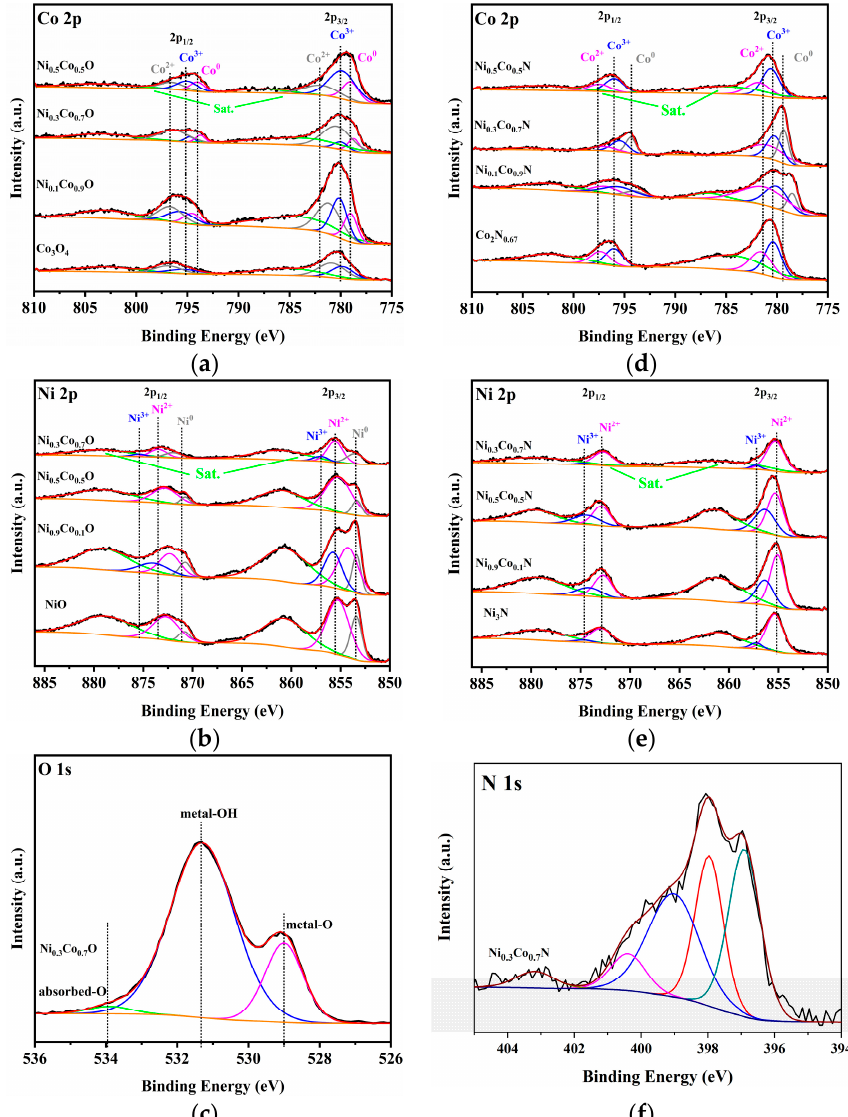
Figure 7. XPS spectra of ( a ) Co 2p for Ni x Co 1 − x O, ( b ) Ni 2p for Ni x Co 1 − x O, ( c ) O 1s for Ni 0.3 Co 0.7 O, ( d ) Co 2p for Ni x Co 1 − x N, ( e ) Ni 2p for Ni x Co 1 − x N, and ( f ) N 1s for Ni 0.3 Co 0.7 N.